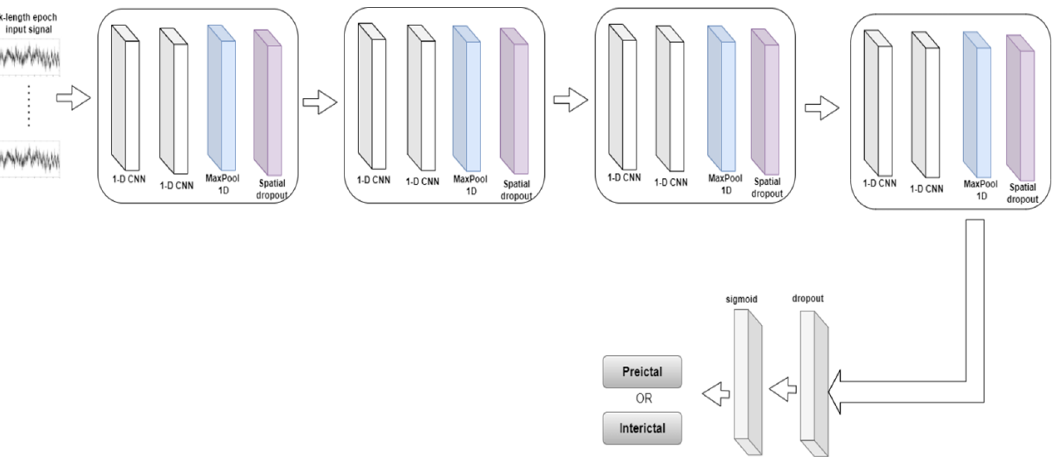
Figure 8. Second proposed deep learning model architecture.